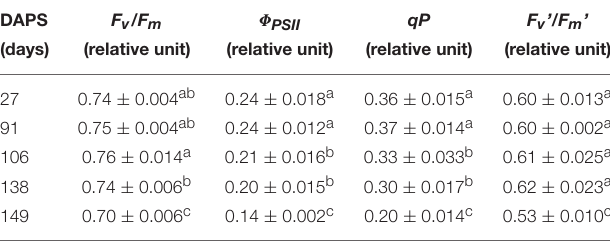
TABLE 1 | Chlorophyll fluorescence parameters of seed sarcotesta in Torreya grandis cv. “Merrillii” during seed development in 2015.